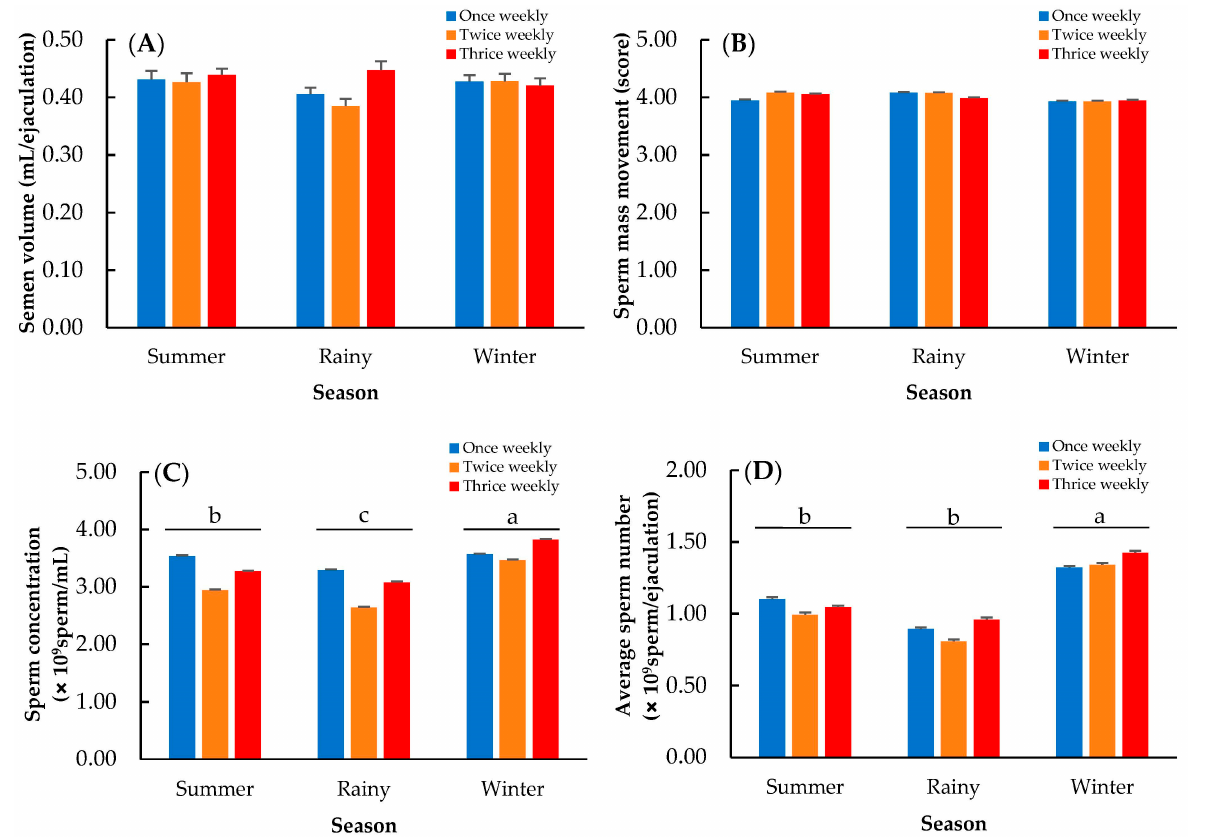
Figure 1. Effect of season on semen volume ( A ), sperm mass movement ( B ), sperm concentration ( C ), and average sperm number ( D ); a, b, c: means followed by different letters differ significantly among seasons at p < 0.01.